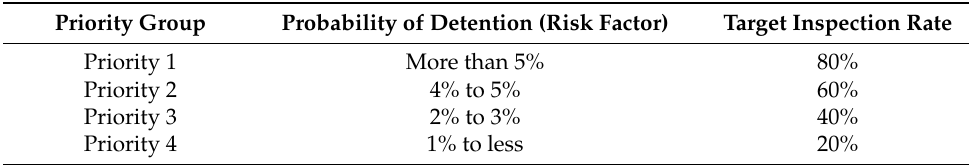
Table 3. AMSA PSC target ship classification